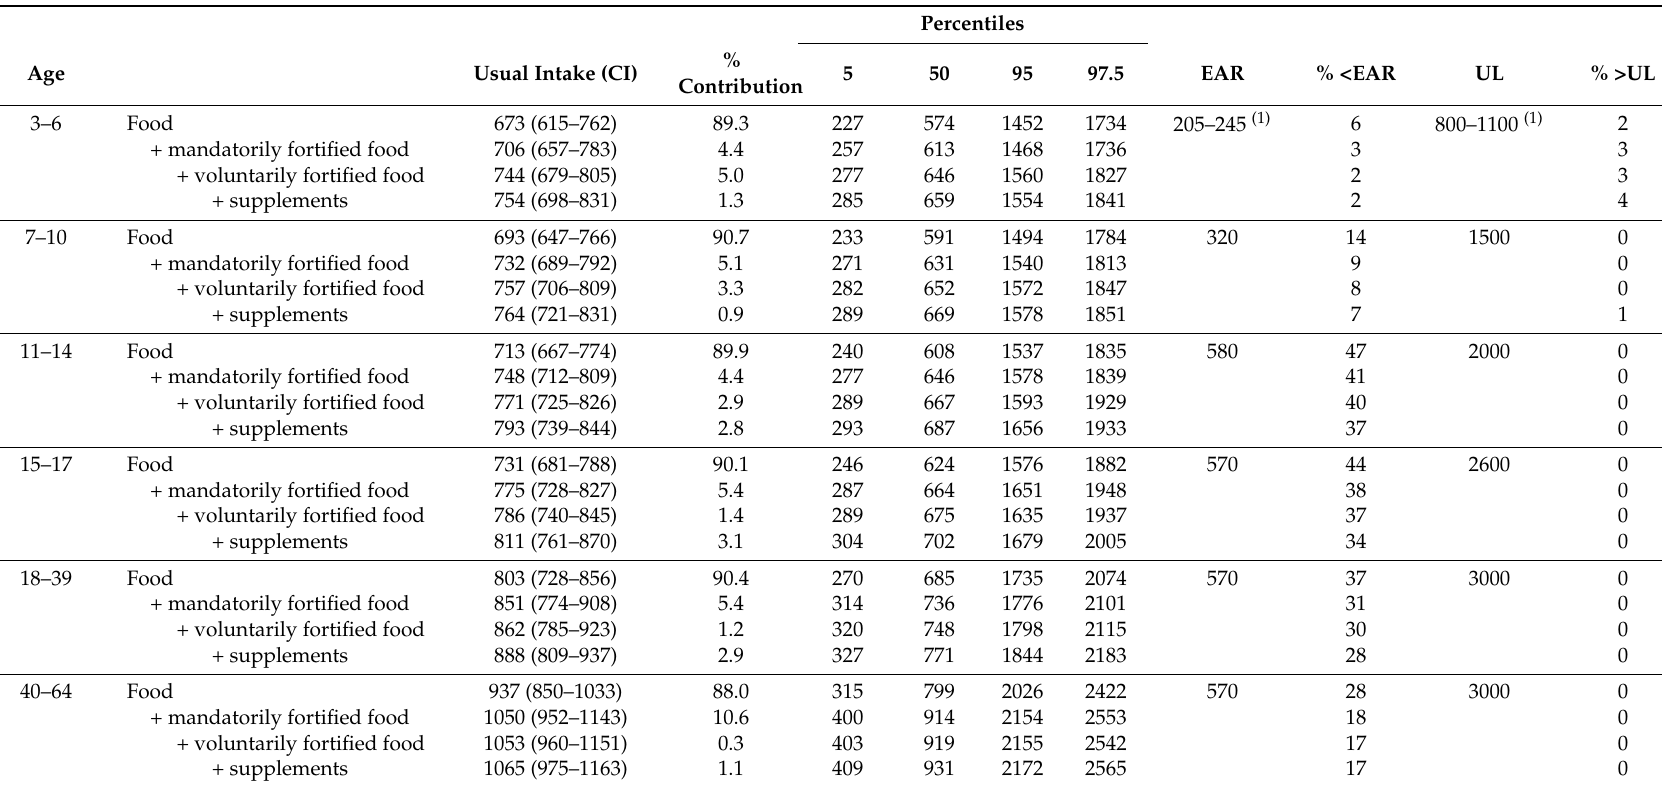
Table 3. Usual intake of vitamin A ( µ g/day) from food, fortified food and supplements in Belgian men (3–64 years), Belgian study on the intake of vitamins A, D, E and K (VITADEK-study)